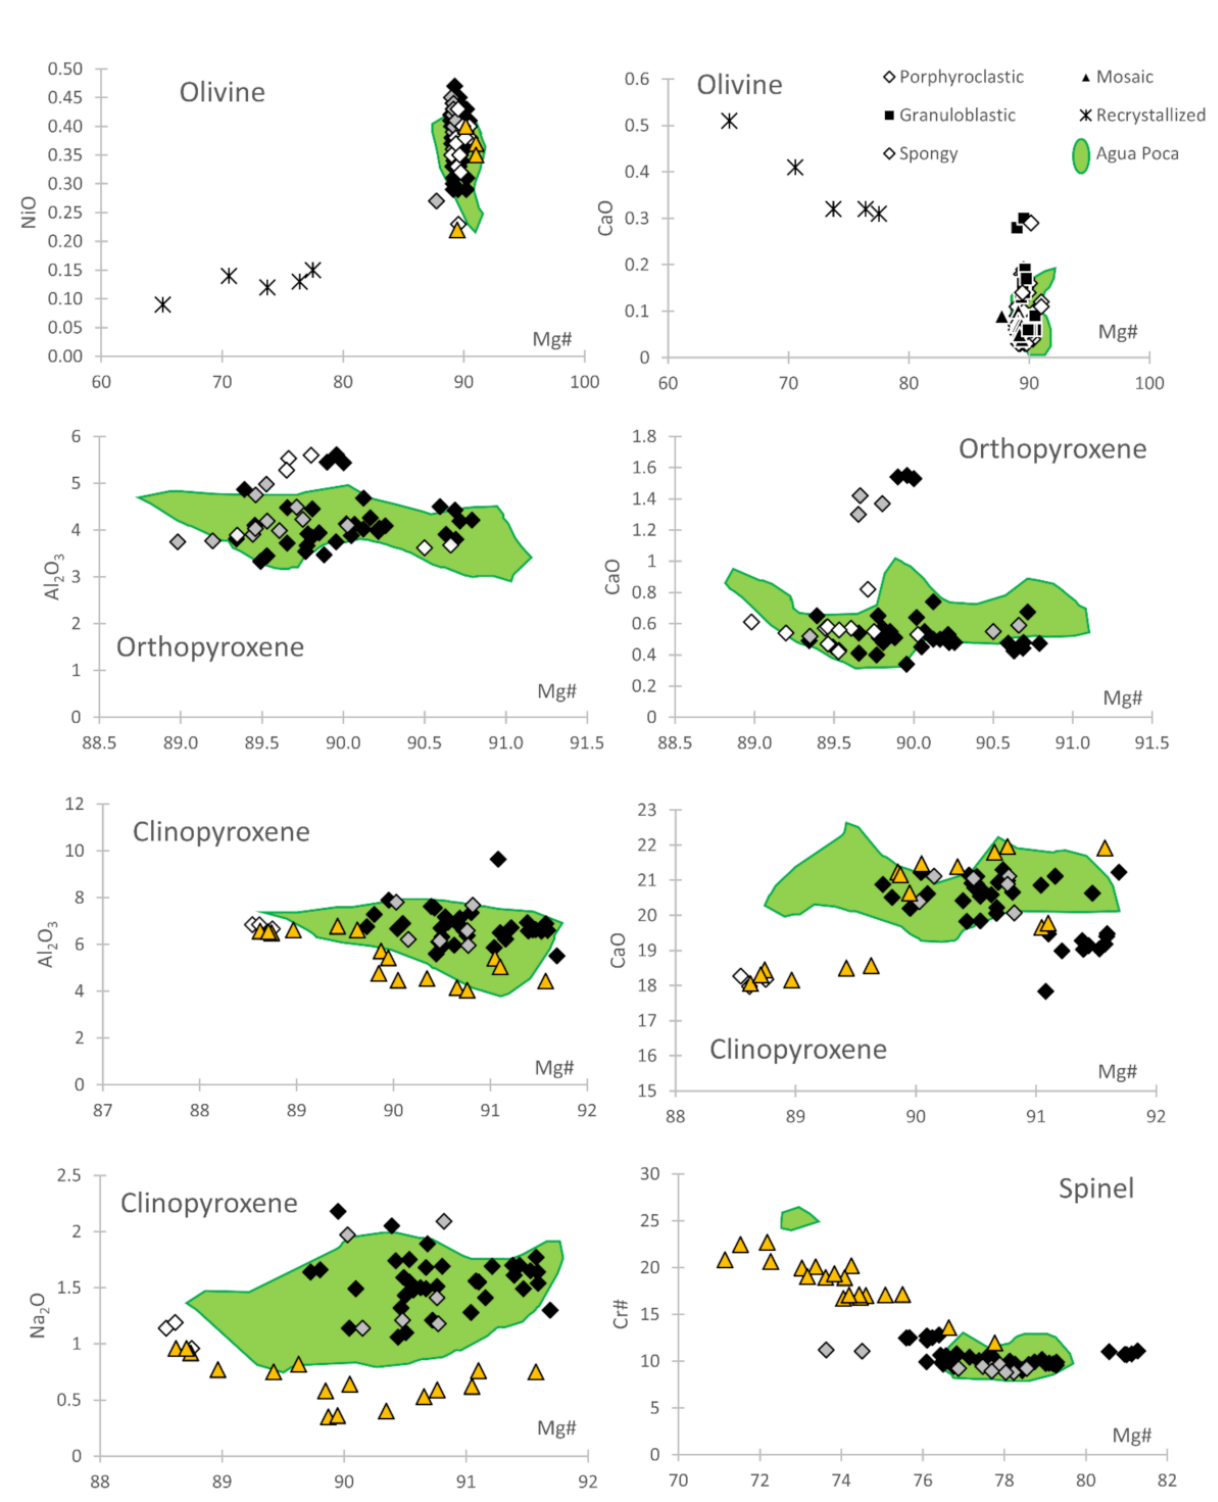
Figure 5. Major element variations in olivine, orthopyroxene, clinopyroxene and spinel from Huanul xenoliths. Green fields are major elements variations of Agua Poca xenoliths [10]. Spinel has Mg# between 73.6–81.3 and Cr# (calculated as Cr# = [Cr 3+ /(Cr 3+ + Al 3+ )] × 100 mol) between 8.8 and 12.8. Reacted spinels form an inverse trend for Mg# and Cr# (Figure 5) showing higher Cr# (11.9–22.7) and lower Mg# (71.1–77.8) compared to